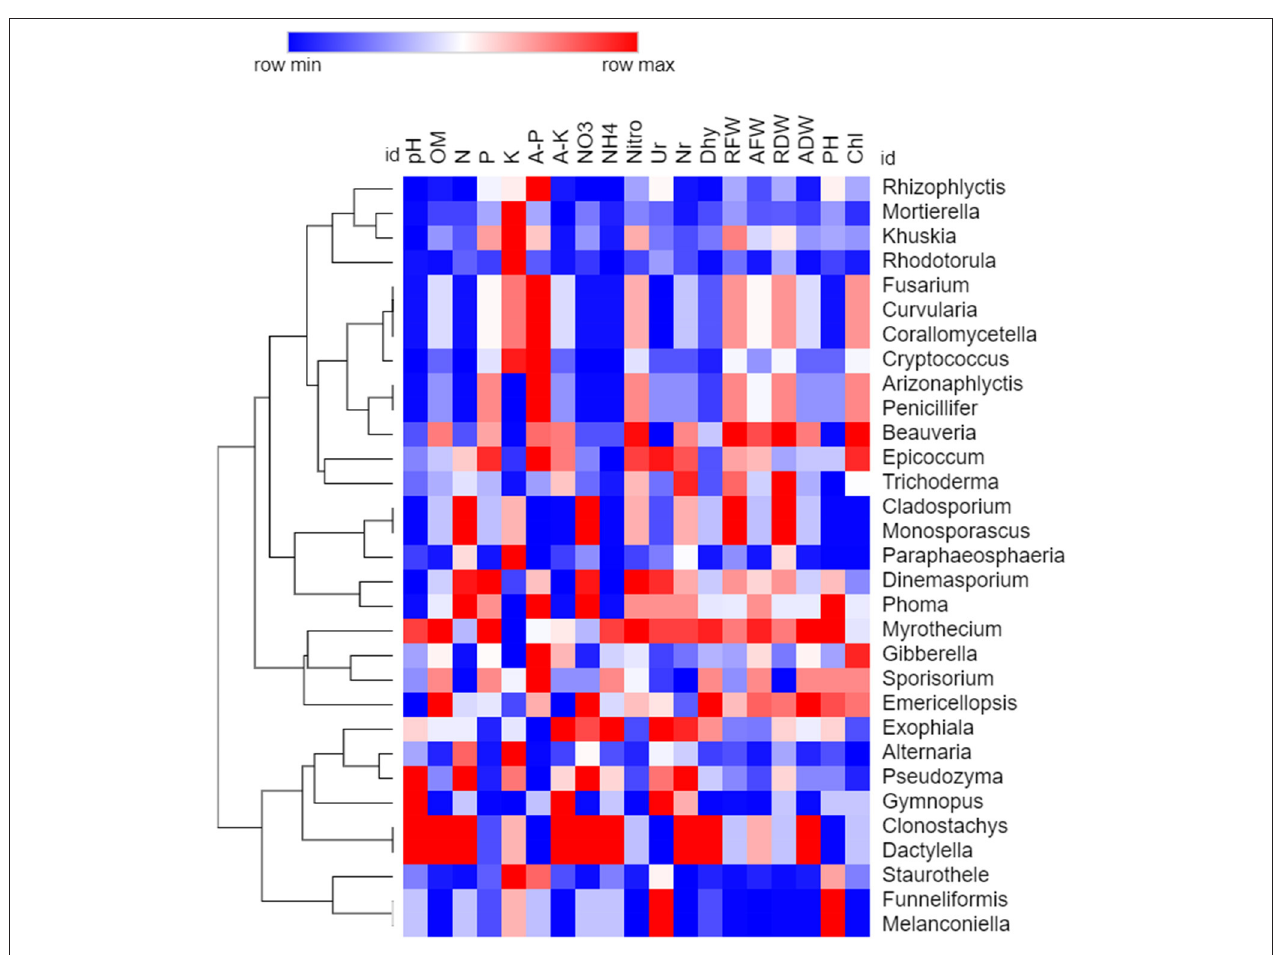
FIGURE 11 | Spearman’s rank correlation analysis between soil chemical properties, soil enzymes, and plant growth parameters with fungal communities. The heat map is drawn based on P -value (Higher to minimum p -value indicated through red to blue color, respectively).